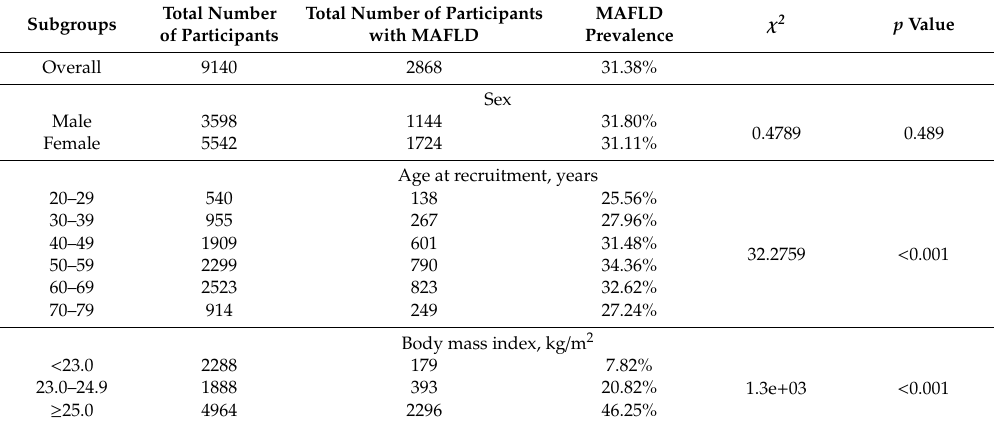
Table 1. MAFLD prevalence stratified by di ff erent